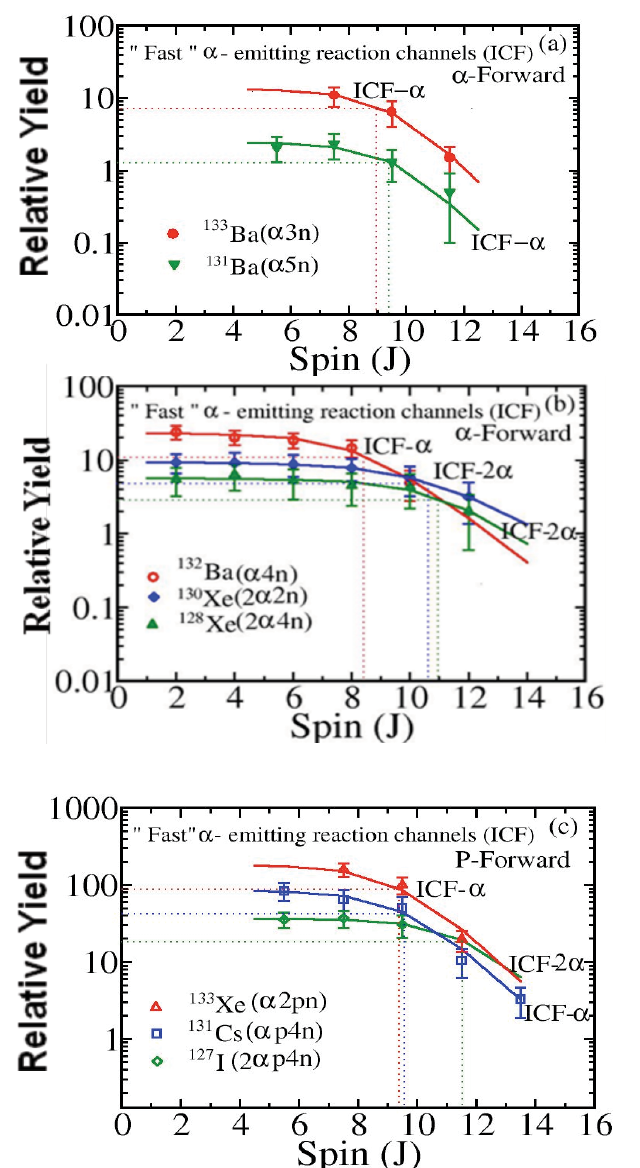
Figure 2. (Colour online) (a)-(c) Experimentally measured spin distribution of evaporation residues produced in ICF for the system 16 O + 124 Sn at 6.3 MeV/nucleon. The curves through experimental points are the best fits using the expression